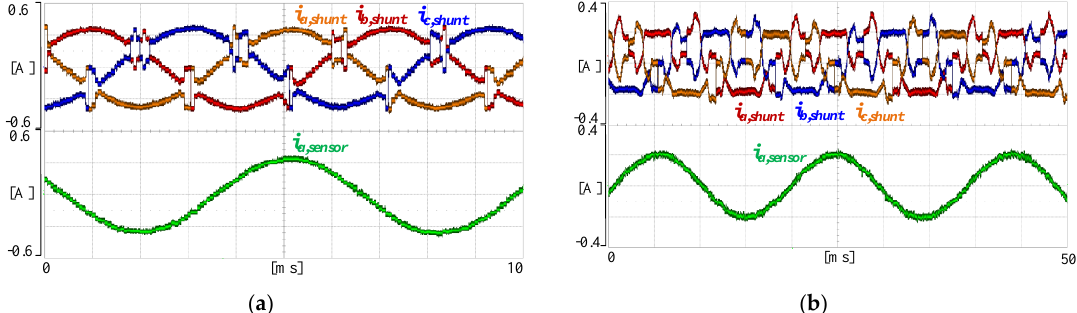
Figure 12. The reconstructed phase current using the shunt resistor method in Areas 1 and 2 (Figure 4a): ( a ) without the average current estimation method; ( b ) with the average current estimation method.